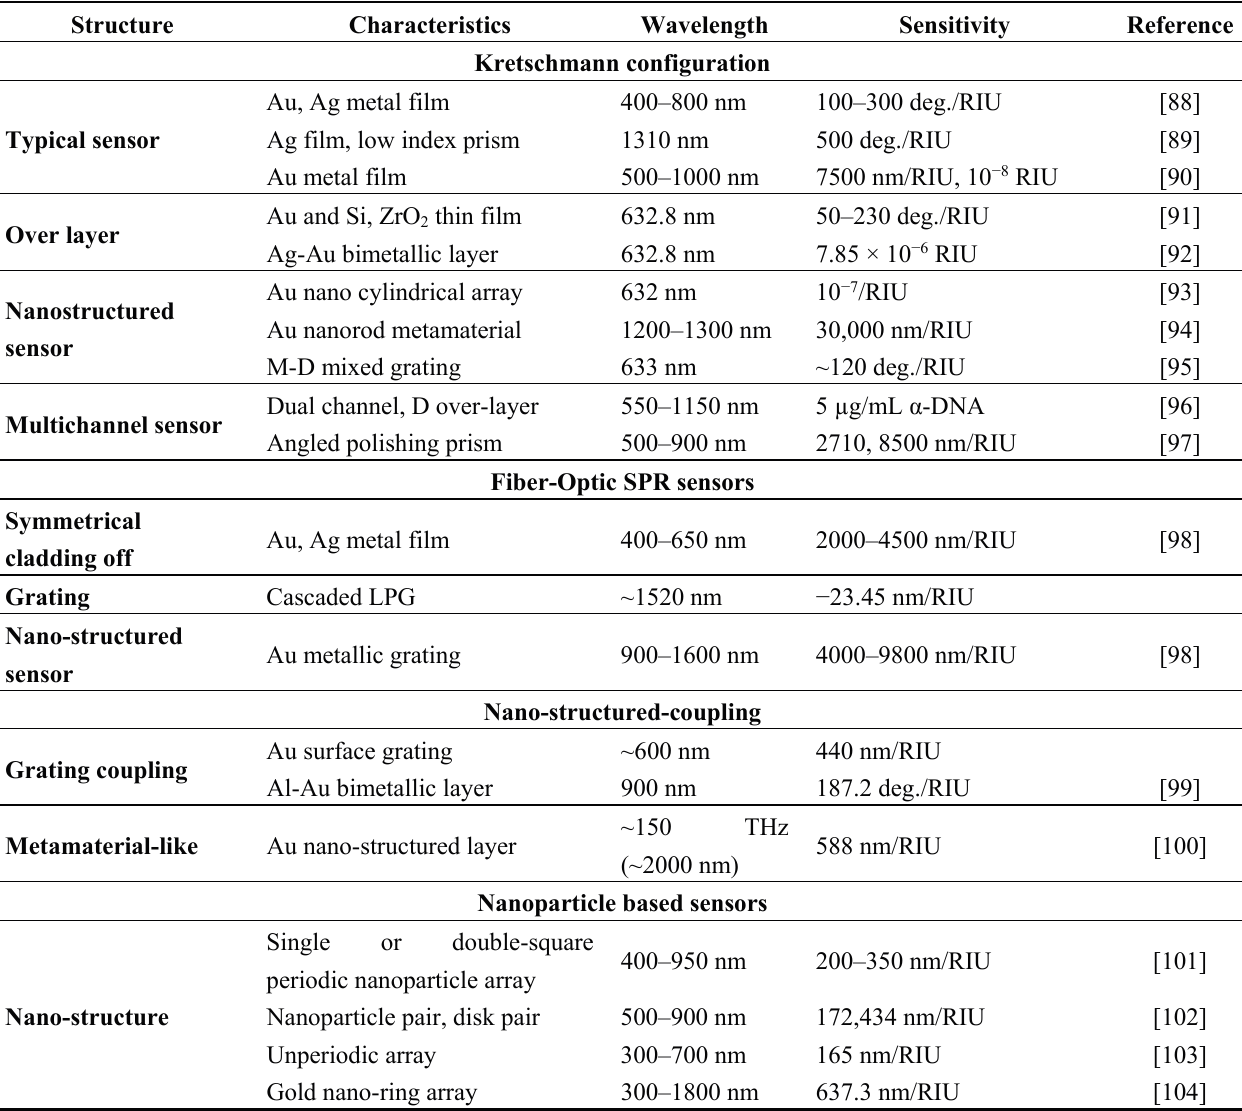
Table 1. Familiar SPR sensors and their